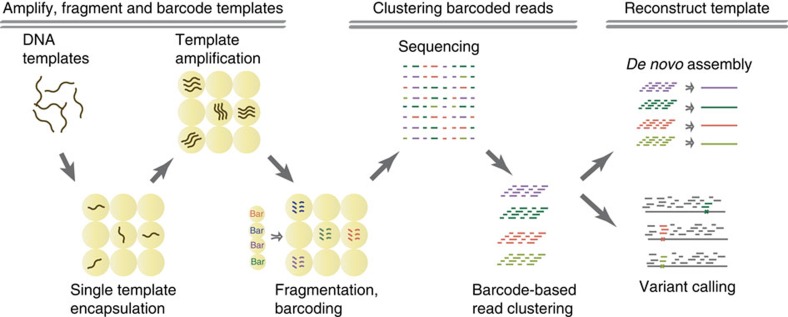
Schematic overview of SMDB.DNA templates are encapsulated into droplets such that most droplets contain zero or one template. Templates are clonally amplified to produce multiple copies in each droplet. Templates are fragmented inside drops, and barcodes are attached to fragments such that each droplet gets a unique barcode sequence. All fragments are sequenced in parallel and resulting reads are clustered based on barcode. Clustered reads are used to reconstruct the sequence or accurately detect SNPs for the template encapsulated in each droplet.